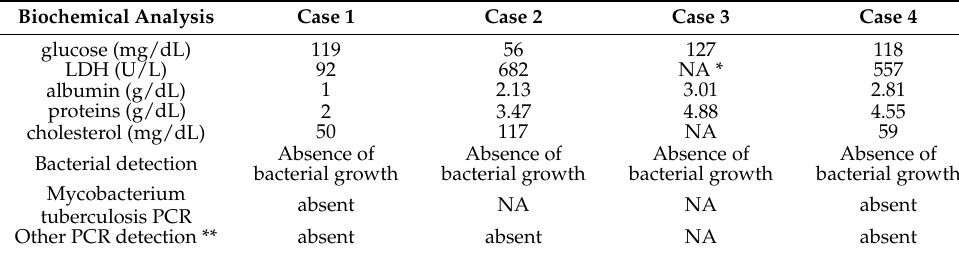
Table A2. Pericardial fluid-biochemical and microbiological analysis. Biochemical